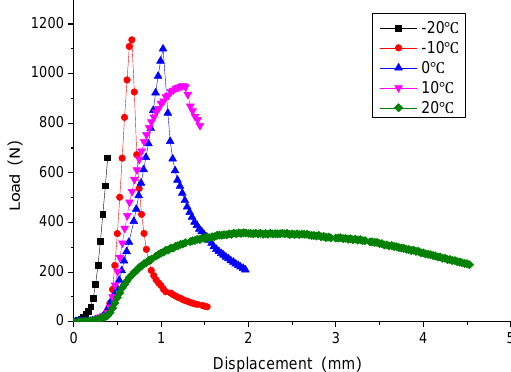
Figure 1. Load-displacement diagram of AC-13 at different temperatures.